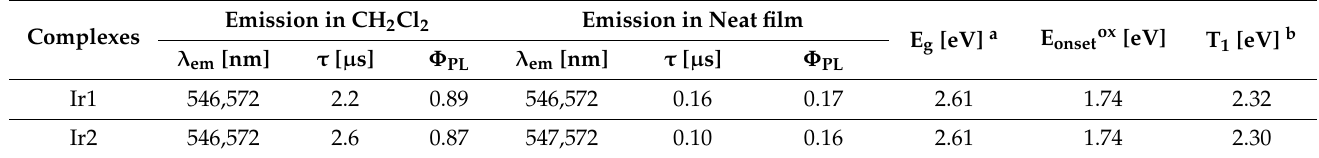
Table 1. Photophysical data of Ir1 and